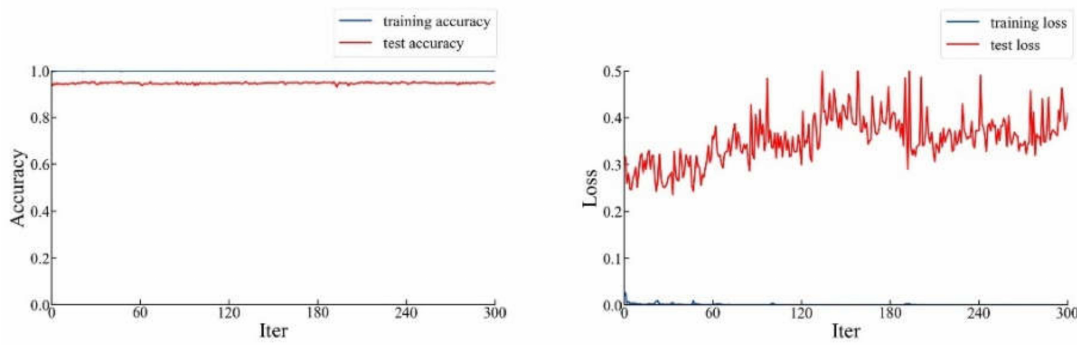
Figure 12. The accuracy and loss curve of the ResNet-101 + FPN in the second step.